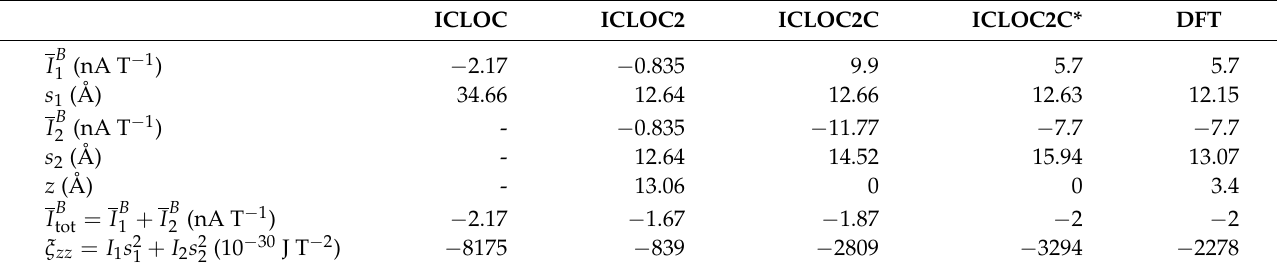
Table 3. Parameters and derived quantities of the nonlinear RCMs used to fit the magnetic shielding scan of Figure 1. The DFT values are also reported: the radii correspond to the locations of the extrema in the plane used to compute the current strength (Figure 3). The set of parameters of the ICLOC2C* model were obtained by fixing the current strengths at the values retrieved from